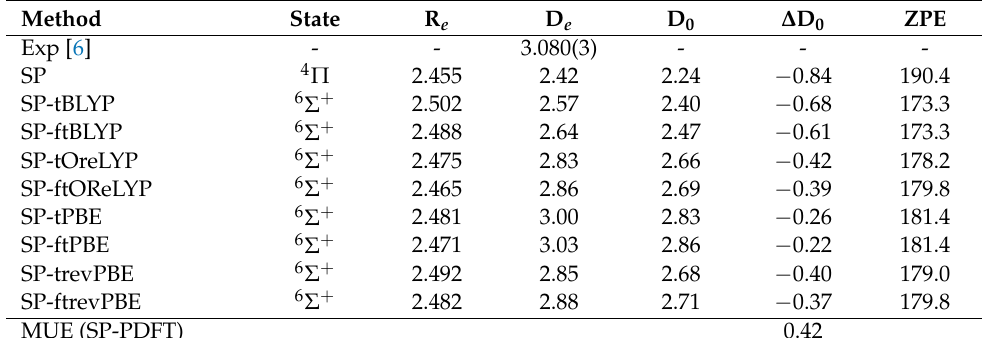
Table 9. Dissociation energies (eV), equilibrium bond lengths (Å), and zero point energies (in cm − 1 ) for NbSi in the ground state, computed with a SP wave function.